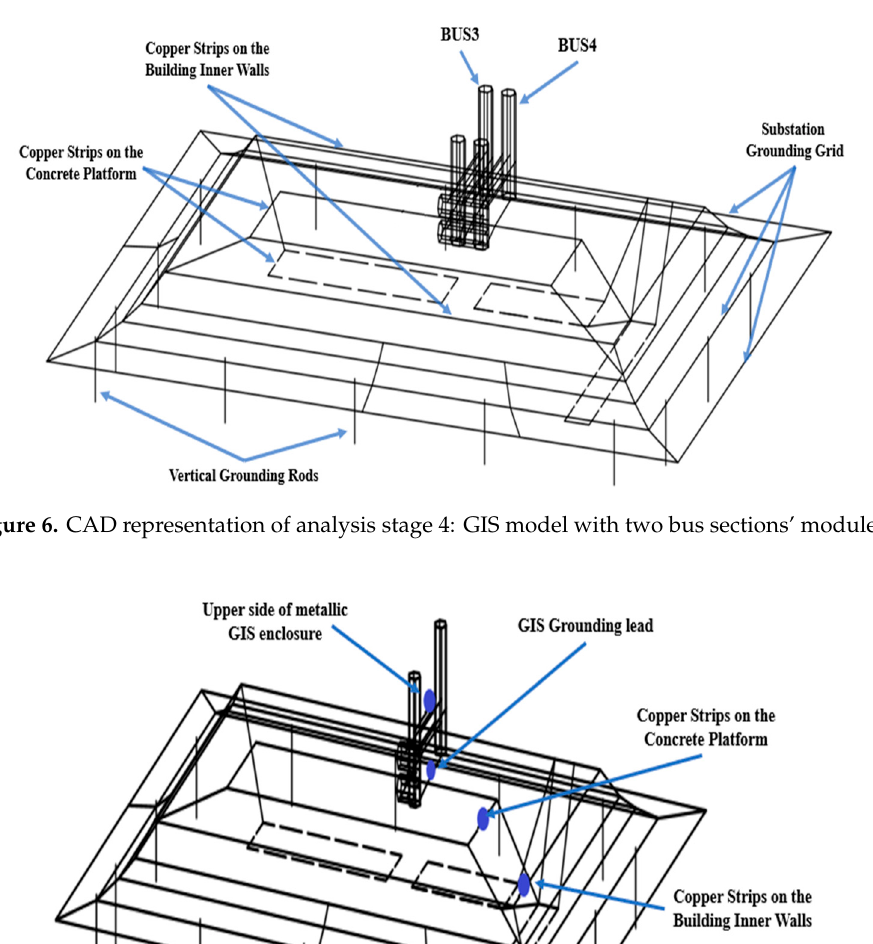
Figure 5. CAD representation of analysis stage 2: GIS model with four bus sections’ modules.